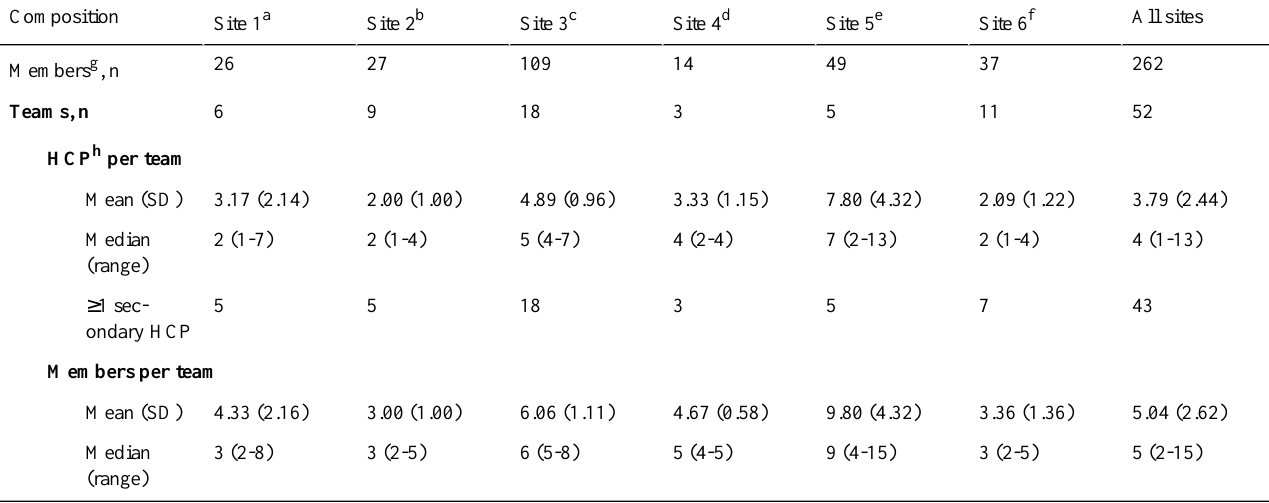
Table 4. Team composition by Patient Loop (team) and by